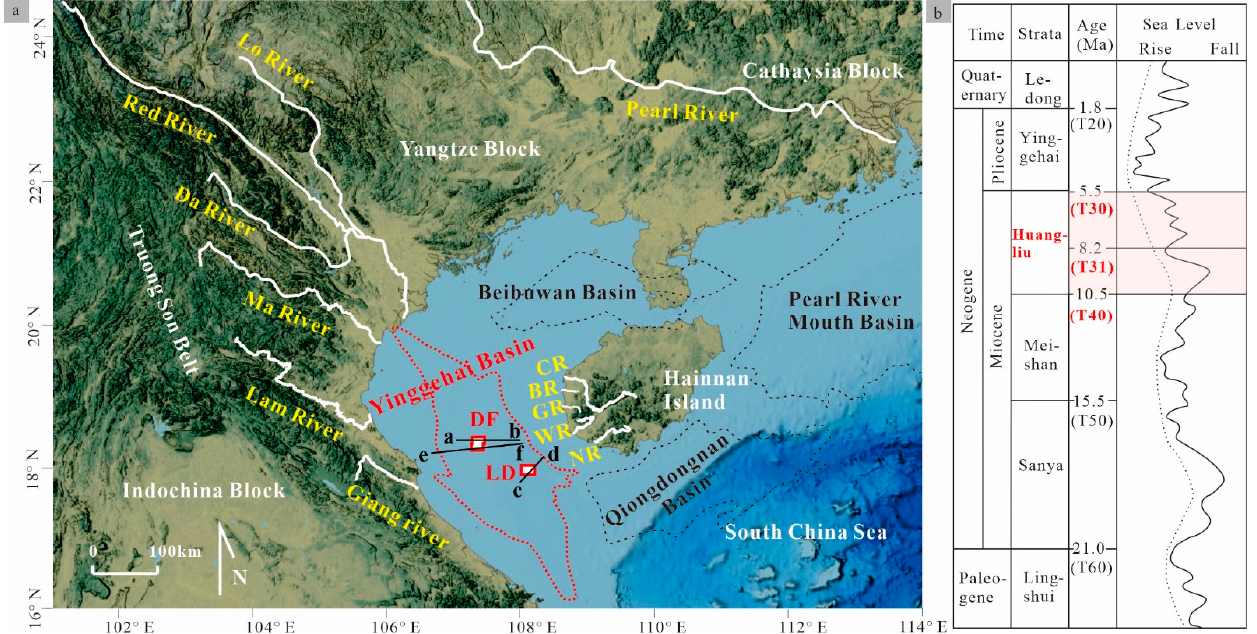
Figure 1. ( a ) Topographic map showing the location of the Yinggehai Basin, which is in the north- western part of the South China Sea, and the adjacent continental blocks, sedimentary basins and chart with sea-level curve (modified from Huang et al. (2020) [11]). T20, T30, T40, T50 and T60 represent the seismic boundaries between the different formations, and the studied strata of the Huangliu Formation are highlighted in the chart. T30 and T40 are the top and bottom surface layers of the Huangliu Formation, respectively, whereas T31 divides the Huangliu Formation into the upper member and lower member.